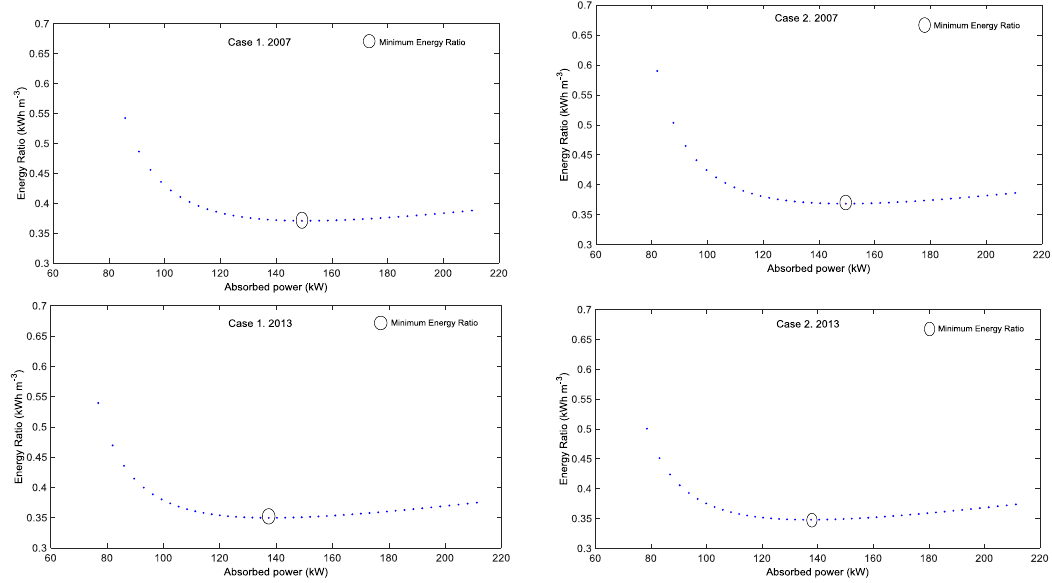
Figure 13. Energy ratio (kWh m −3 ) at each variable speed ratio ( α ) in WUA C.